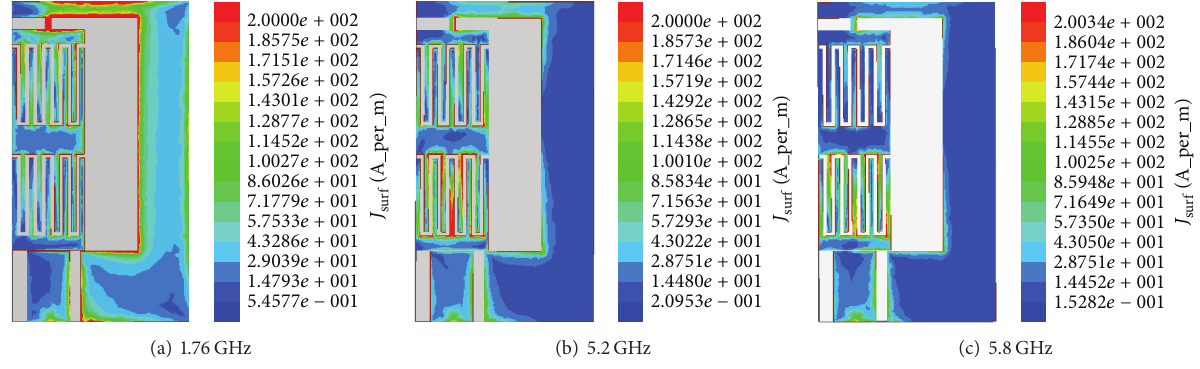
Figure 8: Simulated current distributions of the proposed antenna at (a) 1.76 GHz, (b) 5.2 GHz, and (c) 5.8